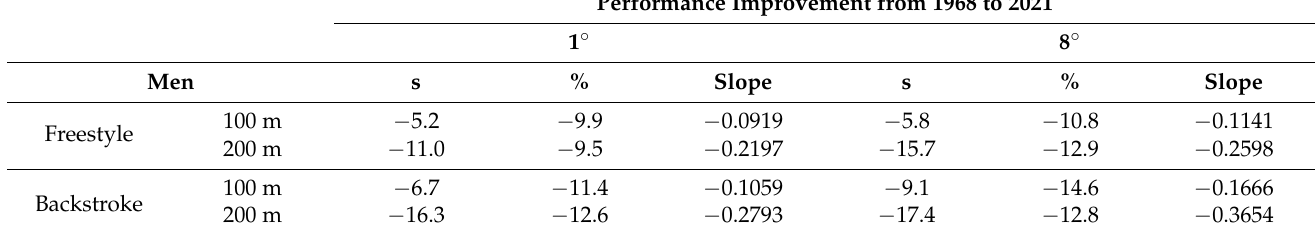
Table 5. Performance improvement in second (s), percentage (%) and slope of the regression line of results over time (slope) from 1968 to 2021 in Freestyle and Backstroke 100 m and 200 m for the men gold medallist (1 ◦ ) and last finalist (8 ◦ ).